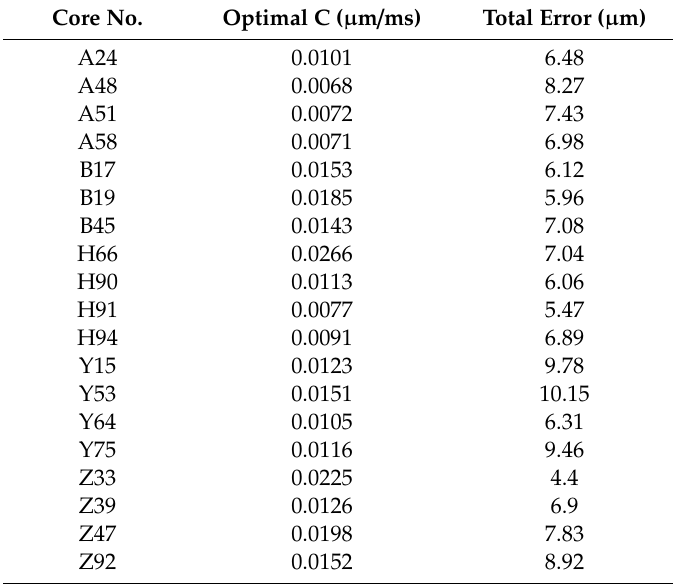
Table 3. The optimal conversion coefficients and total errors for the linear conversion. 208 Core No.